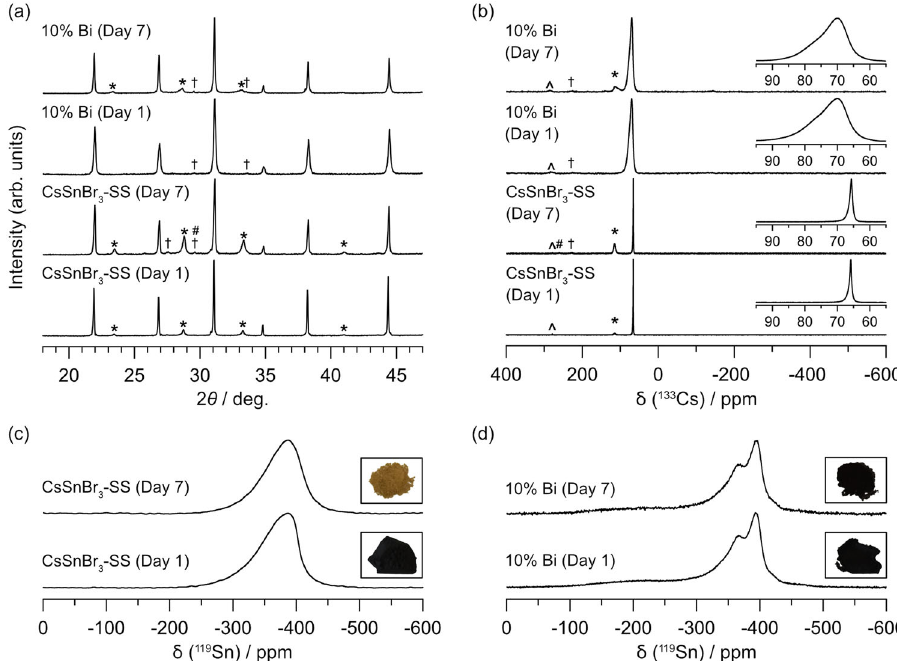
Fig. 3 Exploration of degradation resistance via XRD and NMR. a Powder XRD patterns and b 133 Cs MAS NMR spectra (B 0 = 11.75 T, ω r /2 π = 14 kHz) for solution-synthesized CsSnBr 3 and high temperature synthesized 10% Bi-substituted samples, before and after exposure to 65% relative humidity. Secondary phases include Cs 2 SnBr 6 (*), CsBr (#), and CsSn 2 Br 5 ( † ). Spinning side bands are marked by carets (^). c , d 119 Sn MAS NMR spectra (B 0 = 11.75 T, ω r /2 π = 14 kHz) for solution-synthesized CsSnBr 3 and high temperature synthesized 10% Bi-substituted samples, respectively. Day 1 (before) and Day 7 (after) exposure to a 65% relative humidity. Photo insets are of powdered samples before and after exposure to humidity.